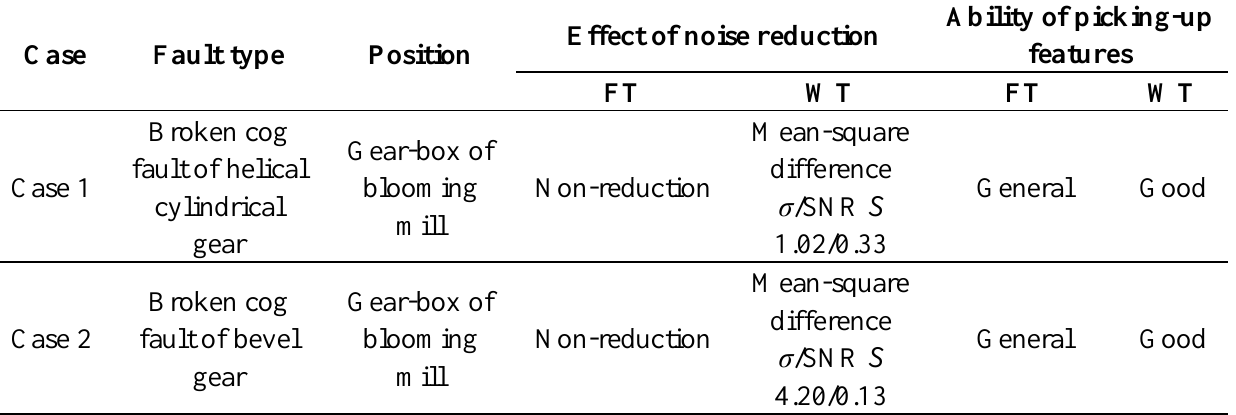
Table 3. Improving SNR and extracting features ability compared between Fourier transform (FT) and wavelet transform